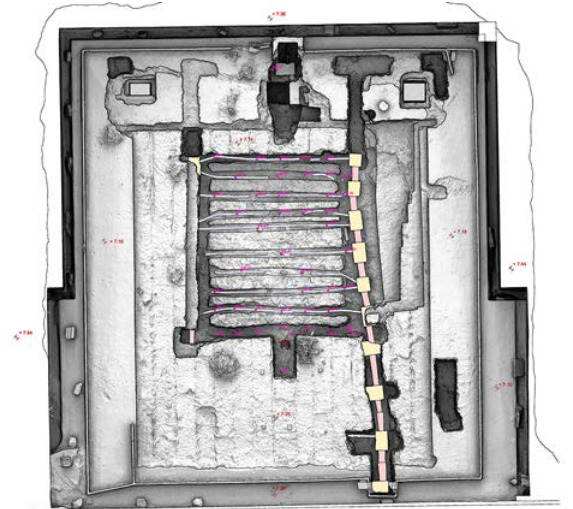
Figure 3. Plan of the terrace above the Grotto with the ancient hydraulic system.